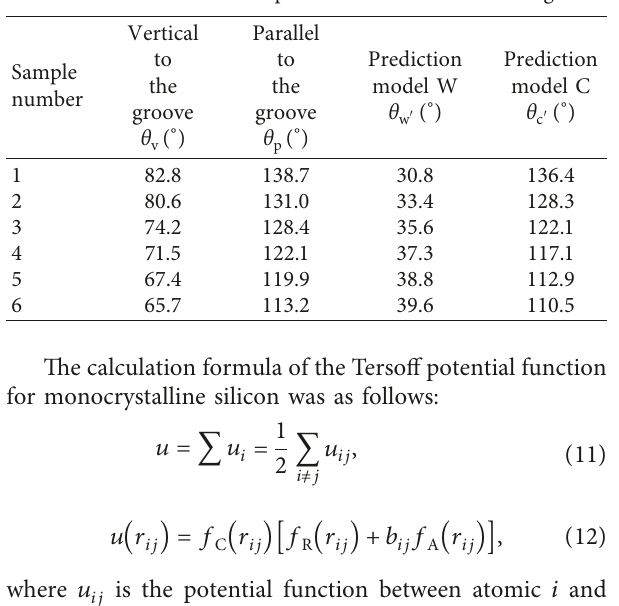
Figure 7: Contact angles of samples: (a) smooth surface; (b) parallel to the groove; (c) vertical to the groove. Table 2: Theoretical and practical values of contact angle.